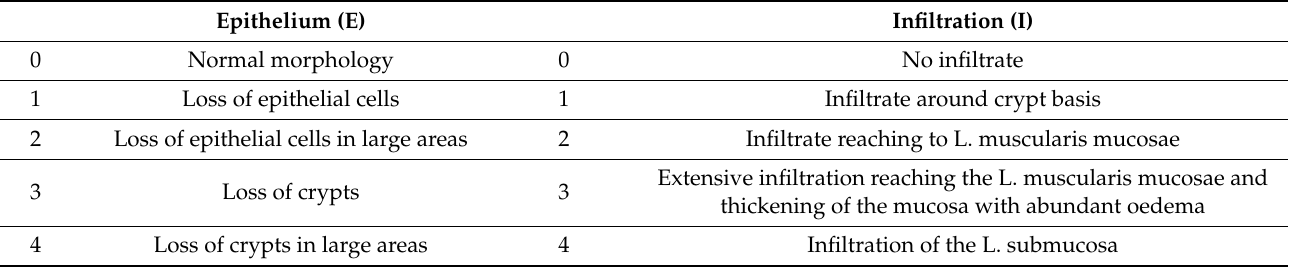
Table 5. Histological score